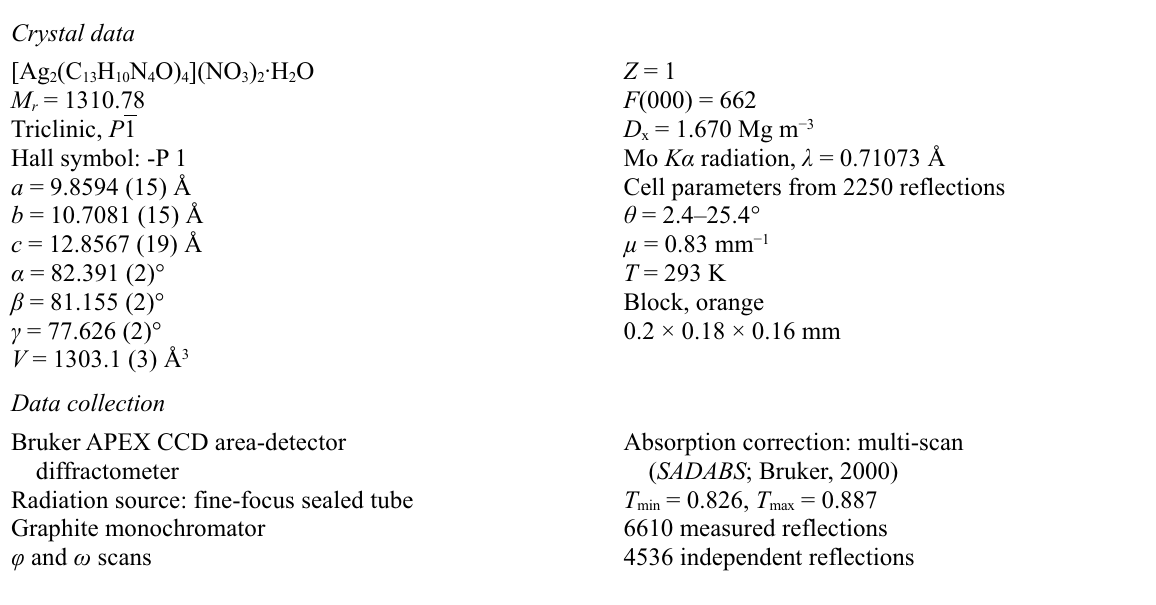
O and hydrogen atoms are omitted for 2